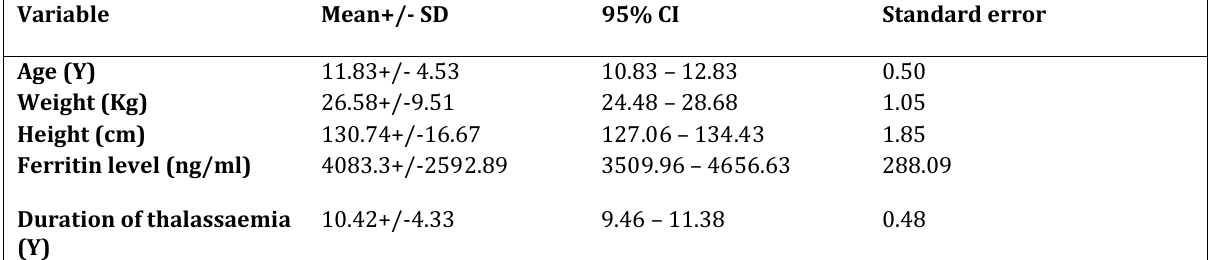
Table1: Demographic, auxological and biochemical variables of patients with thalassaemia major attending to Teaching Hospital Batticaloa, Sri